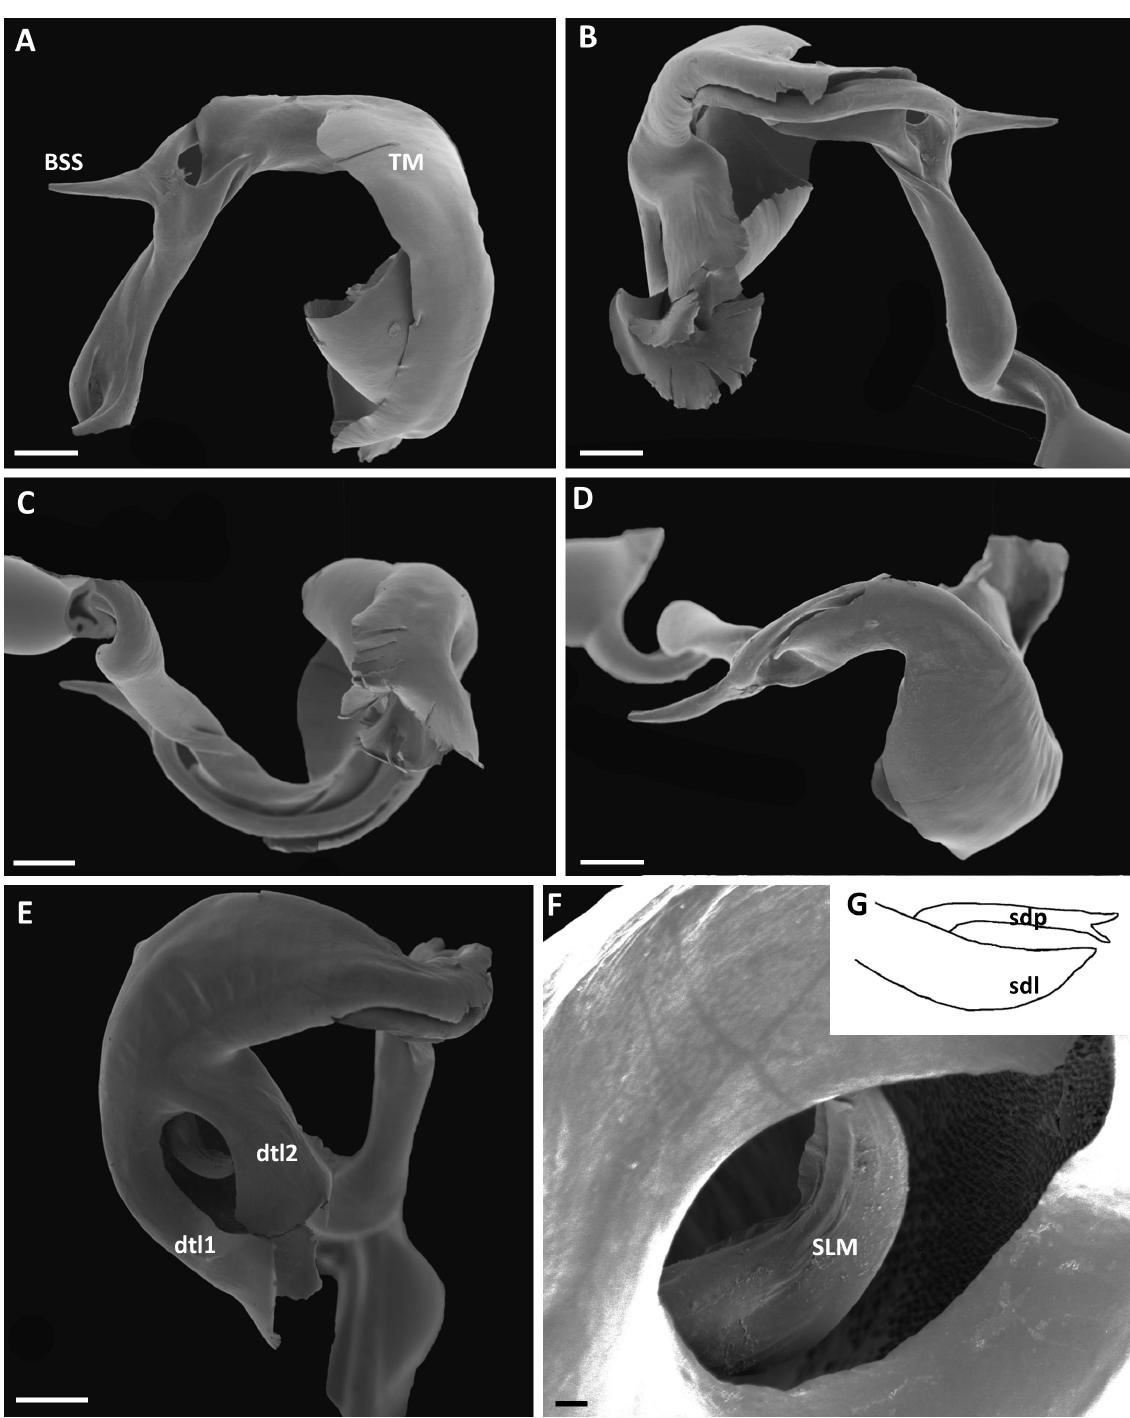
Fig. 76. Xystopyge voluntariorum sp. nov., holotype, ♂ (NHMD 621774). A–F . Left gonopod telopodite. A. Anterior view. B. Posterior view. C. Dorsal view. D. Ventral view. E. Mesal view. F. Mesal view, close-up, showing part of solenomere. G . Right solenomere, tip. Abbreviations: BSS = basal solenomeral spine; dtl1 , dtl2 = distal telomeral lobes; sdl = soloenomeral distal lobe; sdp = solenomeral distal process; SLM = solenomere; TM = telomere. Scale bars: A–E = 0.2 mm; F = 0.02 mm; G not to